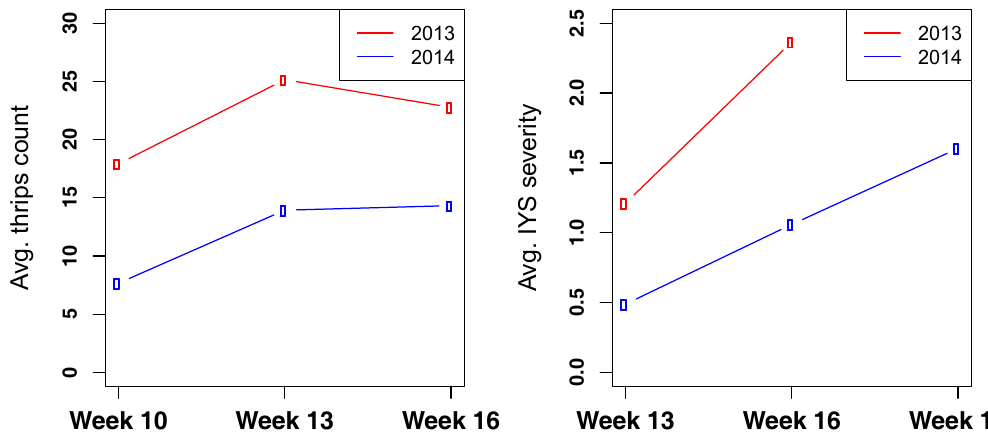
Figure 3. ( Left ) Average number of thrips per counting date for 2013 and 2014. ( Right ) Average IYS severity rating per rating date for 2013 and